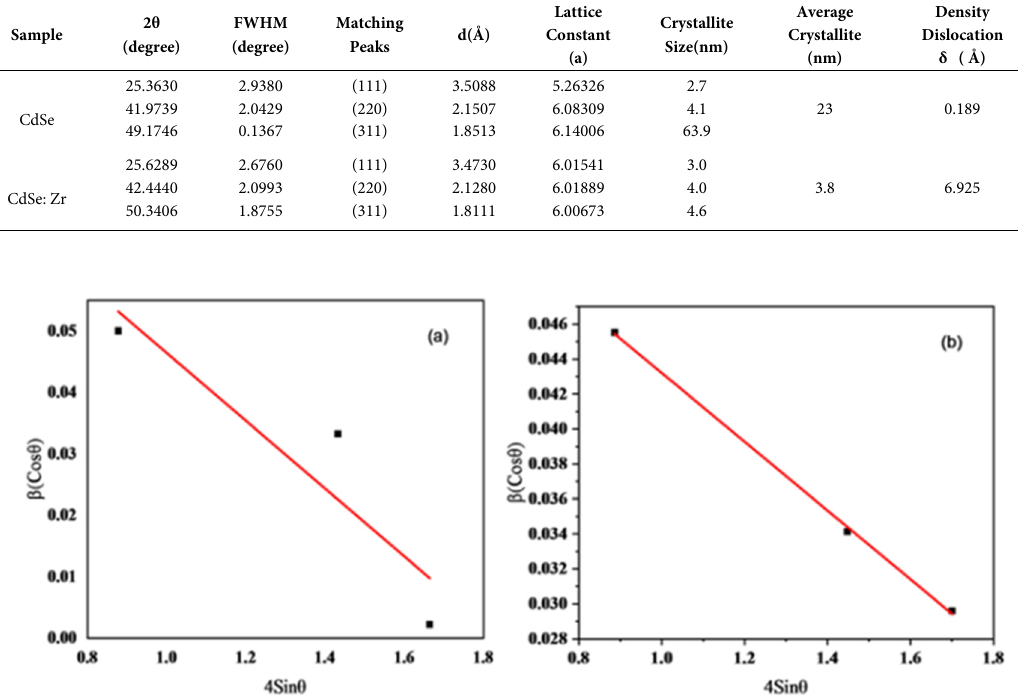
Table 2. Different parameters of CdSe and CdSe: Zr Nanoparticles calculated from XRD spectrum